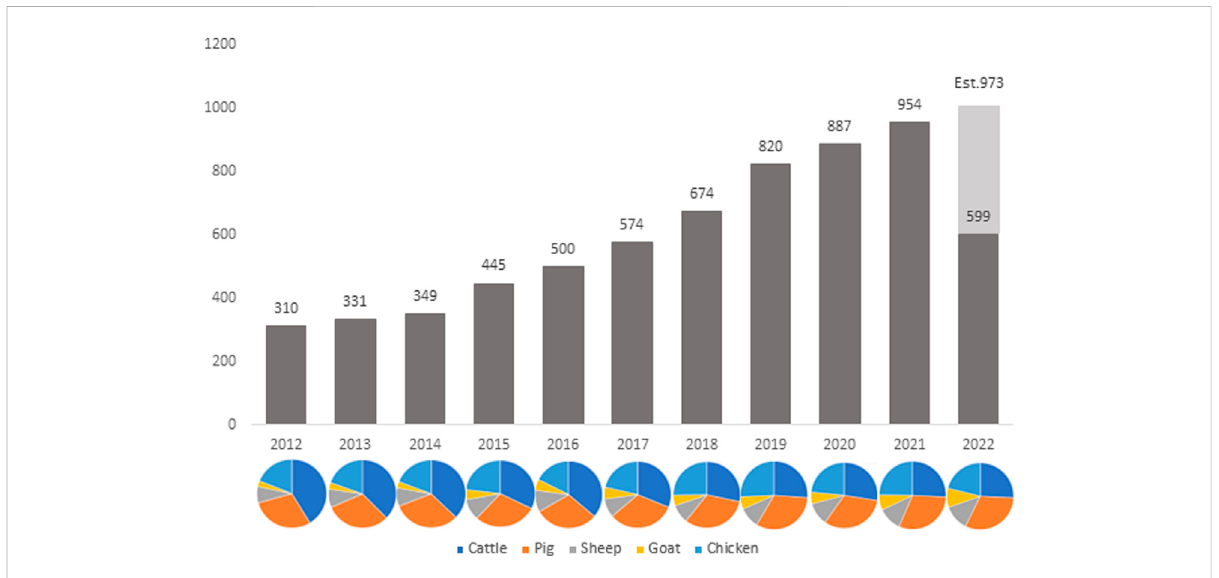
FIGURE 1 Number of published livestock transcriptome studies by year since 2012. Data was compiled via PubMed search: “ TRANSCRIPTOME ” and “ species ” and “ year ” (accessed 12 August 2022).